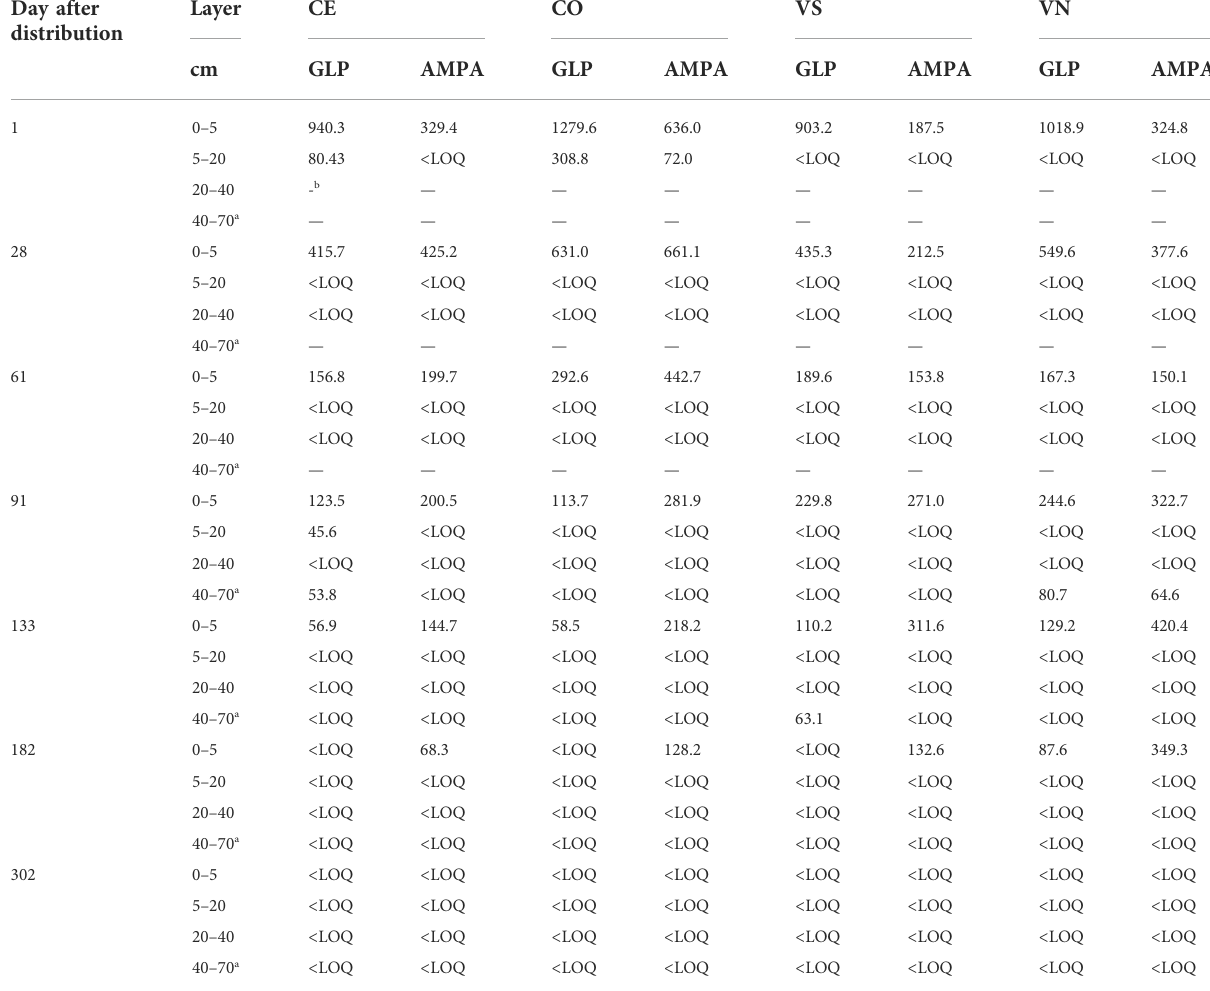
TABLE 4 GLP and AMPA (µg kg − 1 ) detection in soil layers at different times and depths after the distribution. Day after